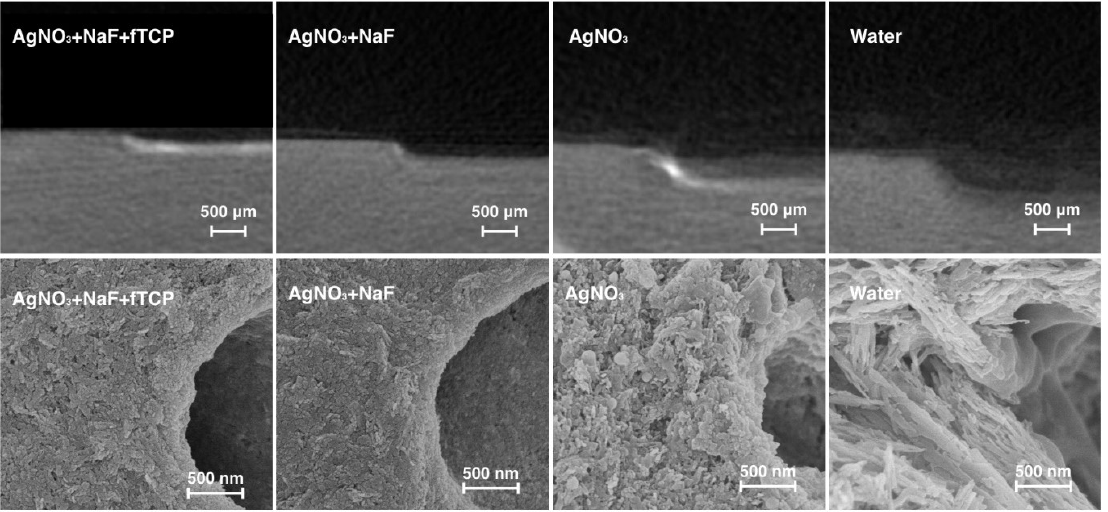
Figure 1. Representative micro-computed tomographs (upper row of the images) of artificial dentine carious lesion, and typical scanning electron micrographs (lower row of images) of surface morphology of artificial dentine caries of the four treatment groups.